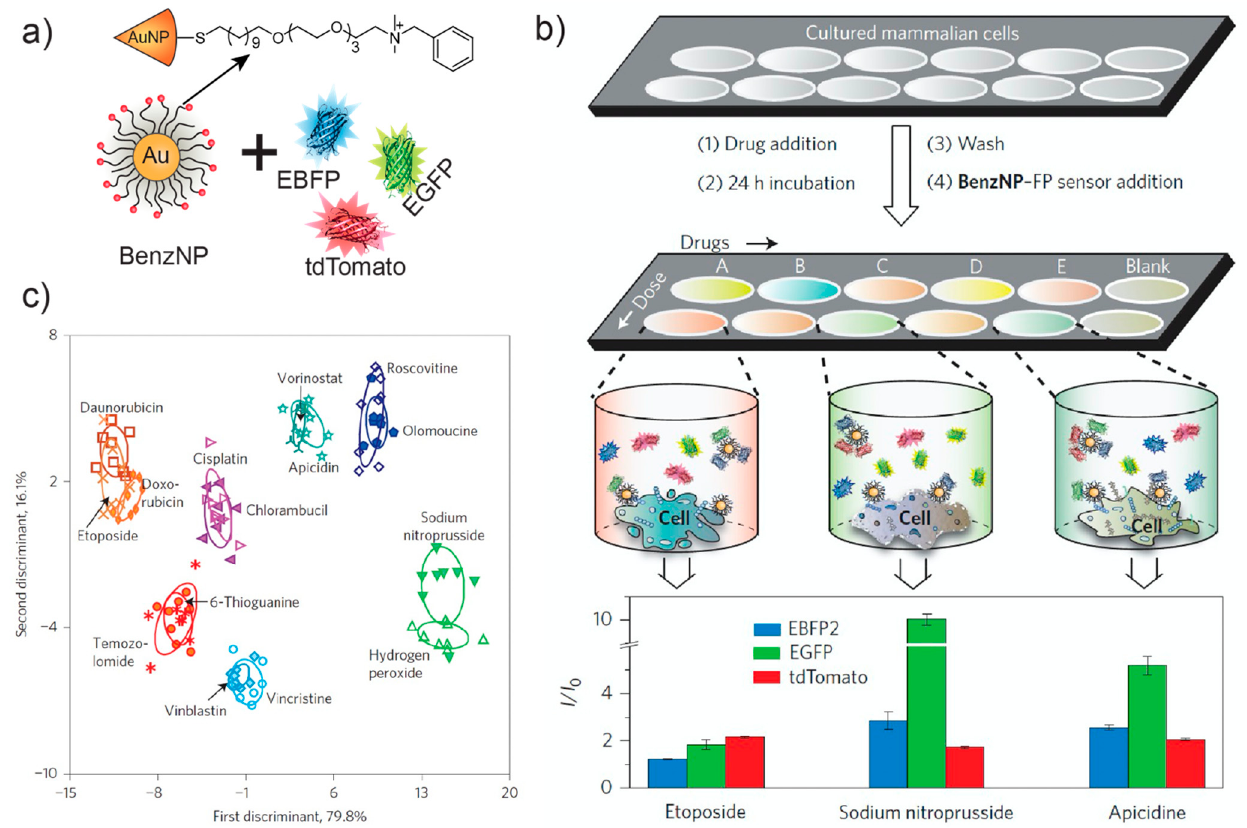
Figure 5. BenzNP-FPs array-based sensor for identifying cancer drug mechanisms. ( a ) Schematic illustration of BenzNP-FPs nanosensor array fabrication. ( b ) Workflow for chemotherapeutics screening using the BenzNP-FPs nanosensor array. ( c ) LDA classification of fluorescence responses from different drug mechanisms. Reproduced with permission from [95]. Copyright 2014 Springer Nature.